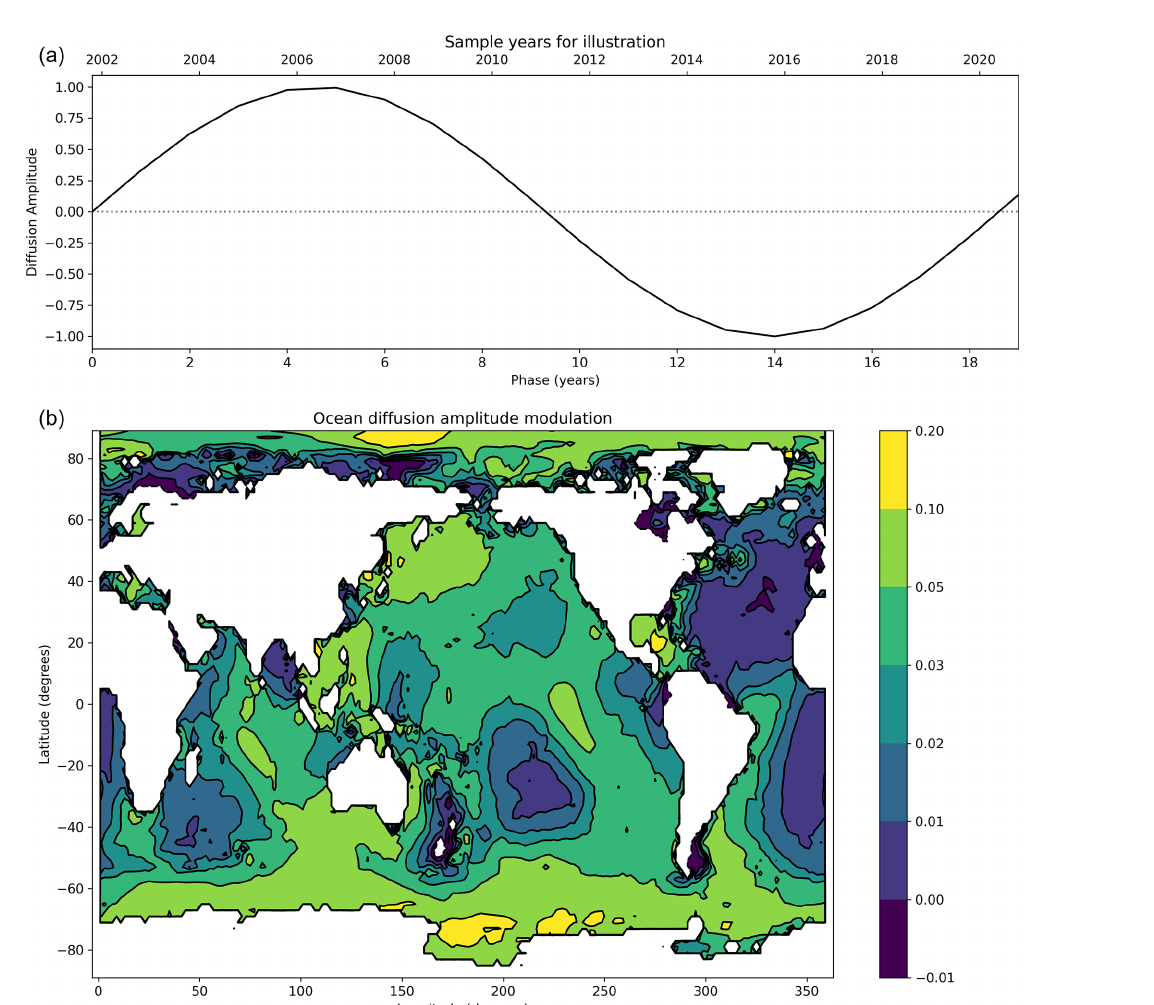
Figure 1. (a) Variation in time of the modulation (with reference year for illustrative purposes on the top axis). The tidal modulation in the model is (a) T ( t ) multiplied by (b) M ( x,y ), multiplied by 1.0 for the constant run, or a scaled function in the scaled run – see Eq. (1). (b) Geographical distribution of the modulation of tidally driven diffusion by the 18.6-year lunar nodal